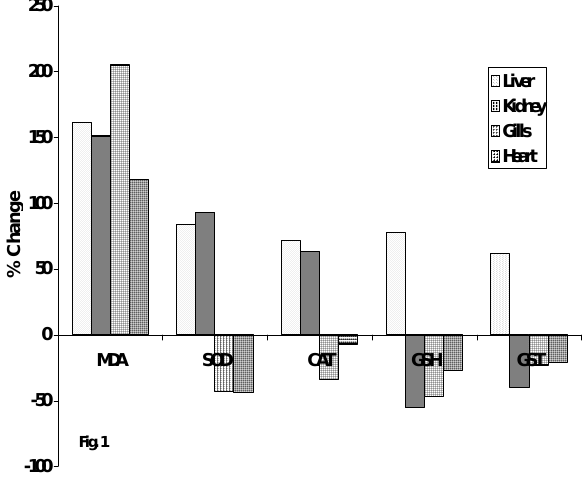
Figure 1: The effect of 2.5 ppm butachlor on the activities of superoxide dismutase (SOD), catalase (CAT),